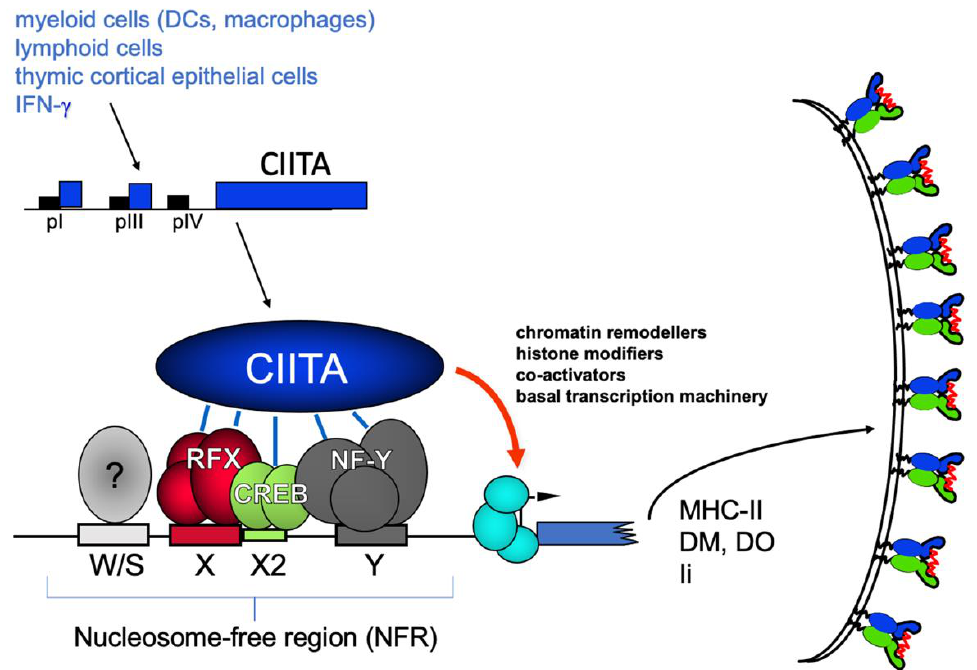
Figure 2. The master regulator CIITA and the major histocompatibility complex (MHC)-II enhanceosome.